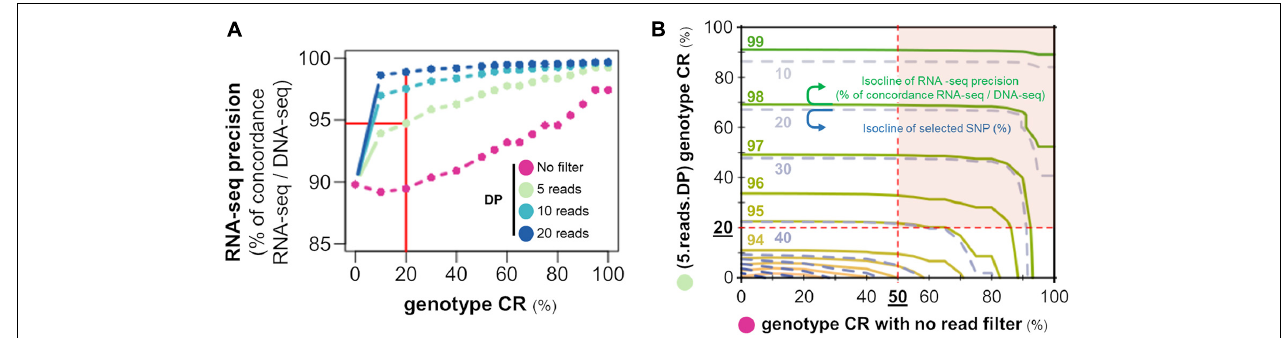
FIGURE 4 | The passage from SNP to GT necessitates a read depth threshold. (A) Evolution of the percentage of genotype concordance between RNA-seq and DNA-seq ( y -axis) for the 15 RpRm birds as a function of genotype call rate in the population (CR: x -axis) supported by at least 5 (light green), 10 (light blue), or 20 (dark blue) reads or without read filter (purple curve). The red lines correspond to the criteria used in the further analysis (CR ≥ 20% with a DP ≥ 5 reads) and the corresponding RNA-seq precision. (B) Isoclines of the percentage of genotype concordance between RNA-seq and DNA-seq (solid green lines) and of the percentage of SNPs selected out to the original set (dashed blue lines) according to the CR with no read filter ( x -axis) and the CR with at least 5 reads [(5.reads.DP) genotype CR (%), y -axis]. Red surface: SNPs selected after filtering on (5.reads.DP) genotype CR ≥ 20% and a CR ≥ 50%.